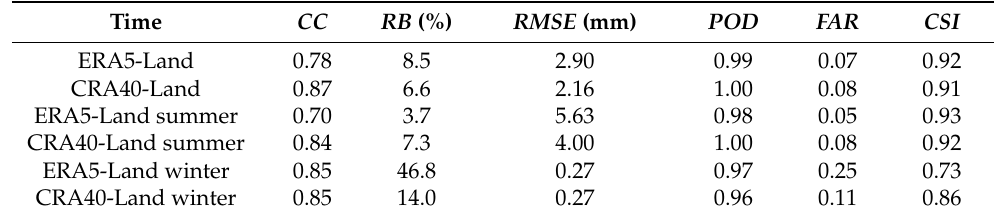
Table 1. Quantitative and classification accuracies of the two reanalysis precipitation products.